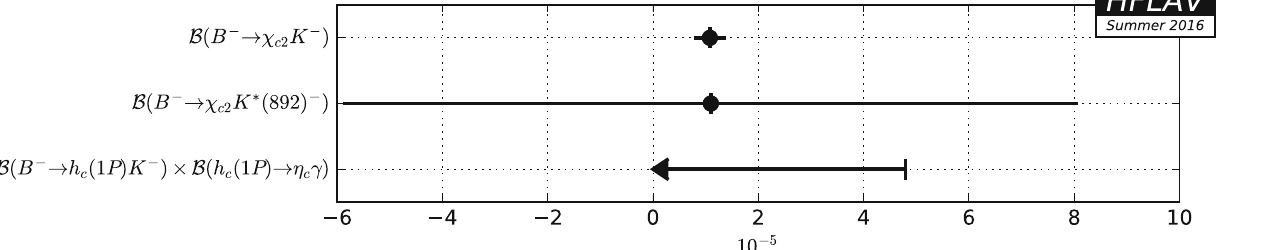
Fig. 131 Summary of the averages from Table